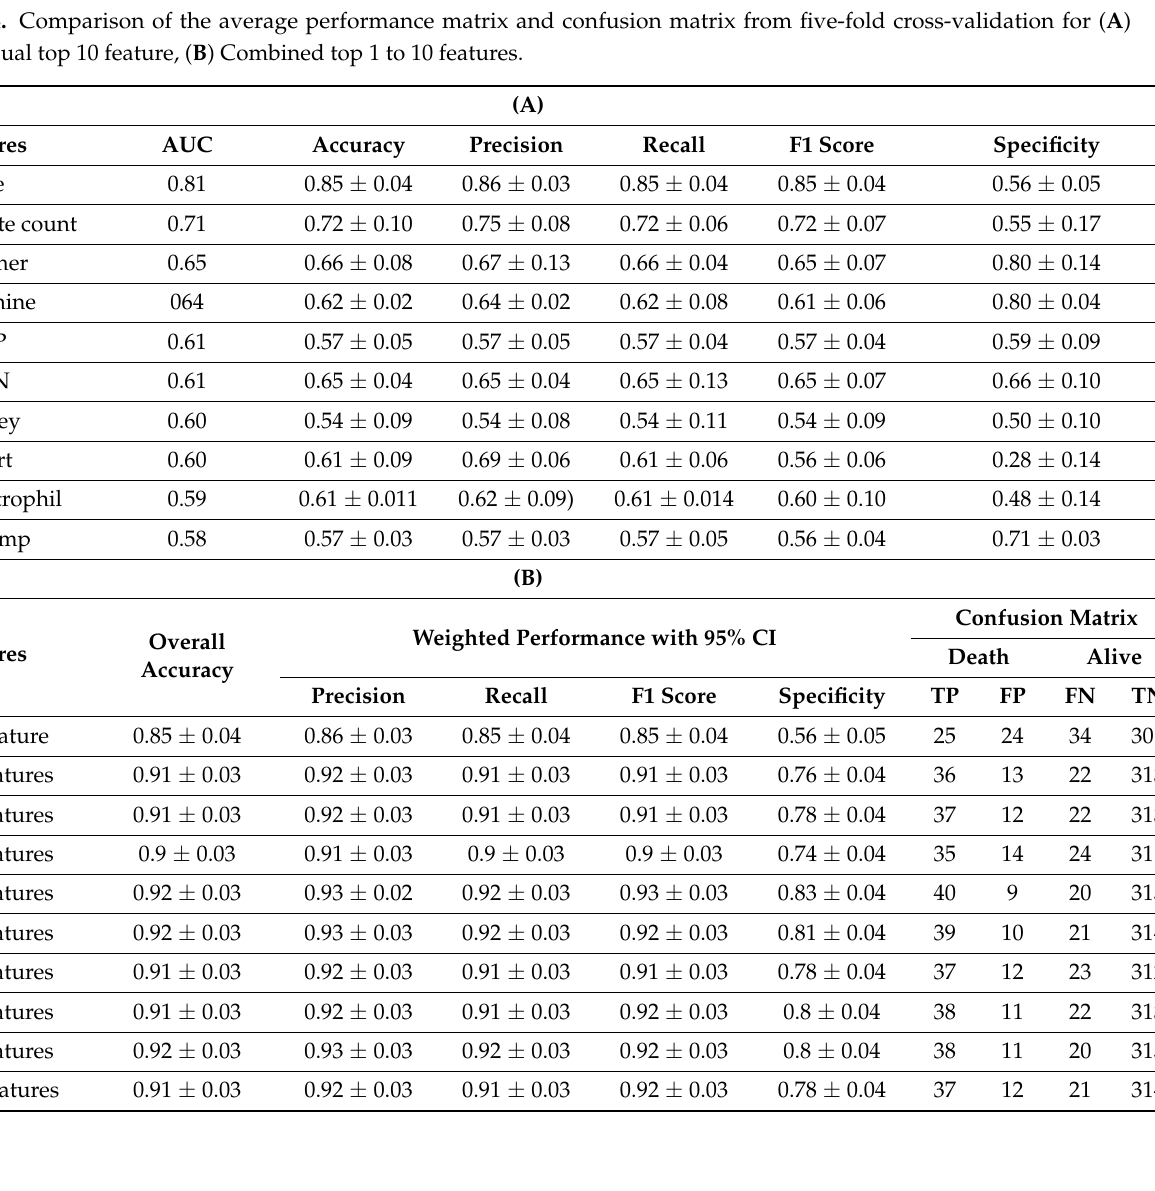
The top-ranked five independent variables: Age, Lymphocyte count, D-dimer, CRP,